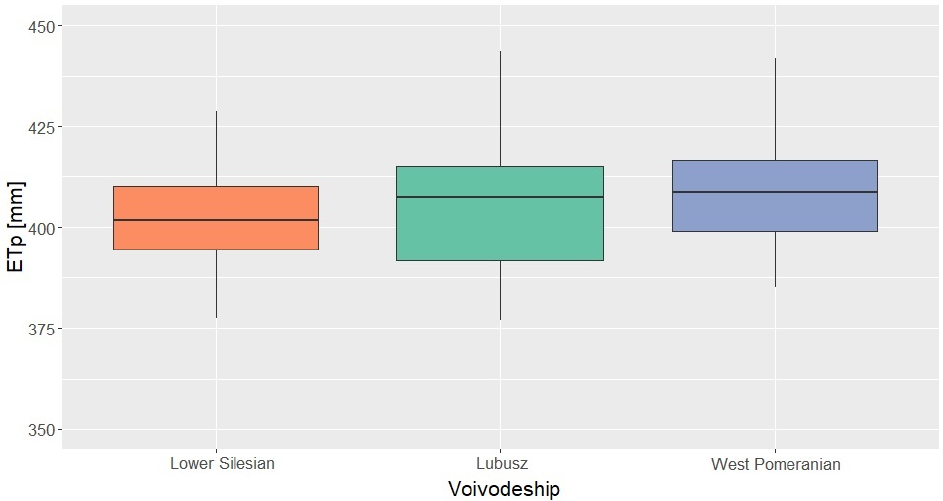
Figure 7. Average water requirements of willow for the analyzed voivodeships during the growing season (3rd decade of May to the end of October) calculated based on data from 1981 to 2010. (SD equaled 12.7, 17.4 and 13.6 for Lower Silesian, Lubusz and West Pomeranian, respectively).